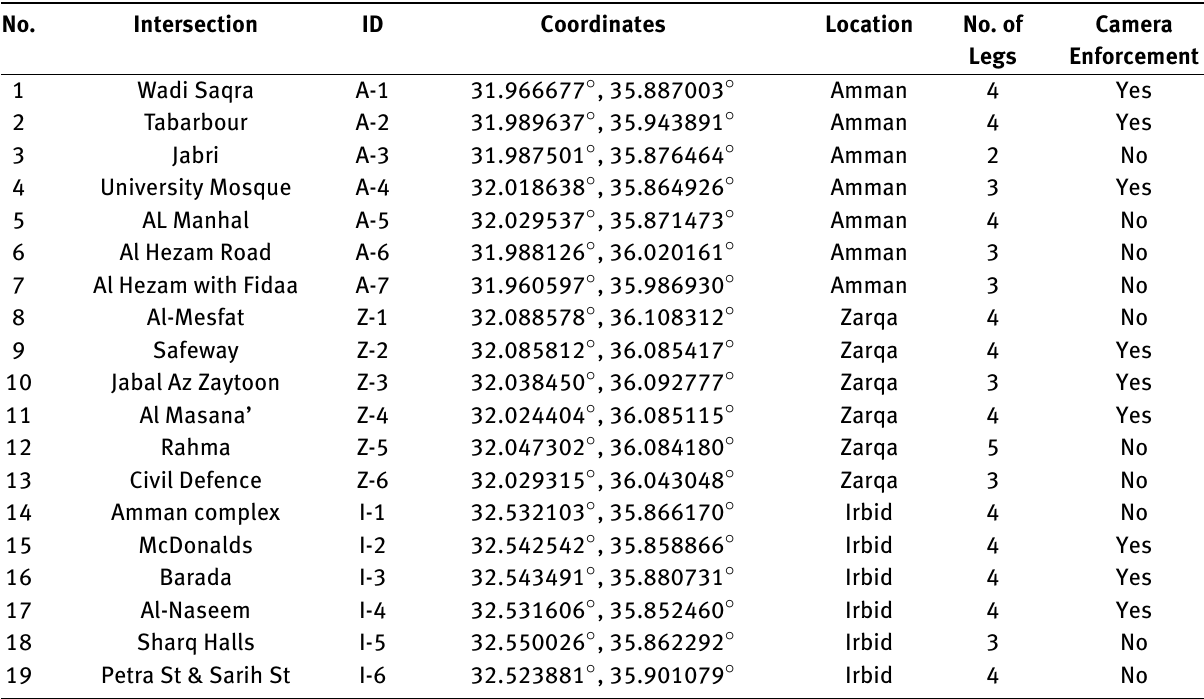
Table 1: Intersections Location, Number of Legs, and Camera Enforcement Condition